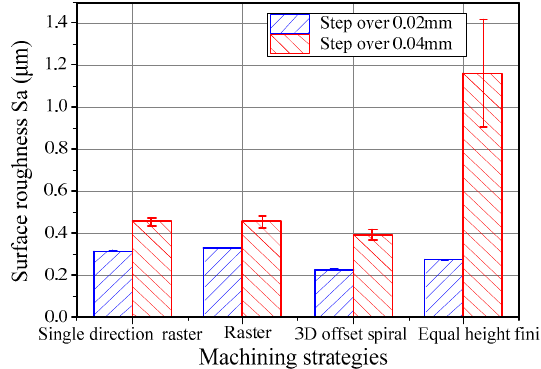
Figure 8. Calculation scheme of the scallop height.